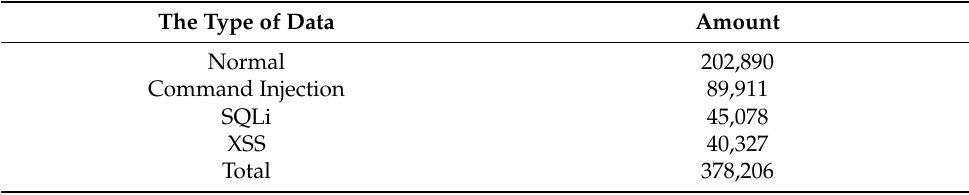
Table 6. The specific distribution of training set.